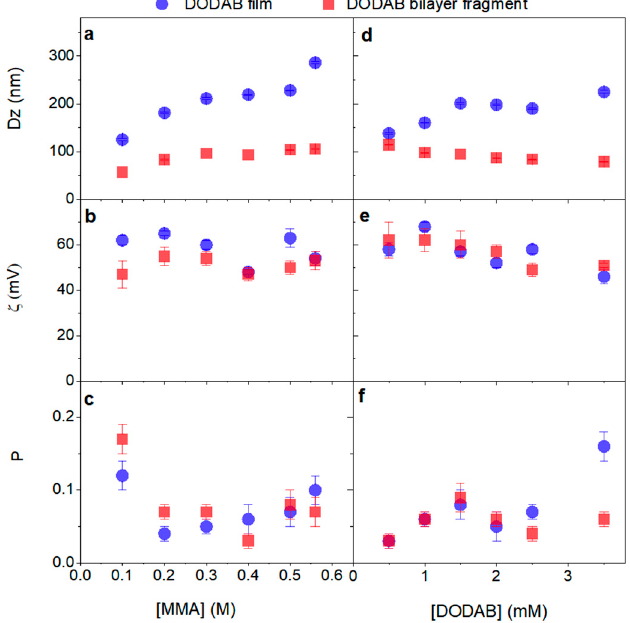
Figure 1. Effect of methyl methacrylate (MMA) concentration ( a – c ) or dioctadecyl dimethyl ammonium bromide (DODAB) concentration on main characteristics of PMMA/DODAB NPs synthesized by emulsion polymerization of MMA in the presence of DODAB ( d – f ). From dynamic light scattering (DLS), mean hydrodynamic diameter (Dz) ( a , d ), zeta—potential ( ζ ) ( b , e ) and polydispersity (P) ( c , f ) were determined for the dispersions in pure water. NPs in dispersion at 1.5 mM DODAB were synthesized over a range of [MMA]. NPs were also synthesized at 0.3 M MMA over a range of [DODAB].